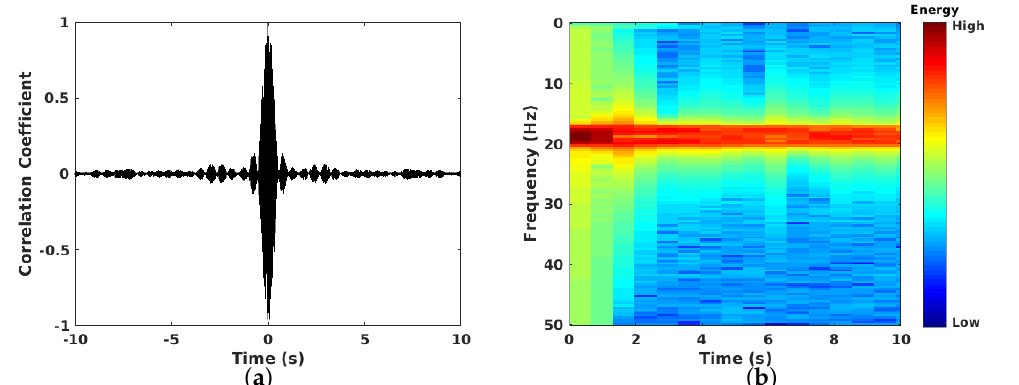
Figure 11. Cross-correlation example between two sensors’ data. ( a ) Casual (positive) and anticasual (negative) symmetric cross-correlation. ( b ) Frequency-time spectrogram where it is possible to distinguish dominant frequencies.